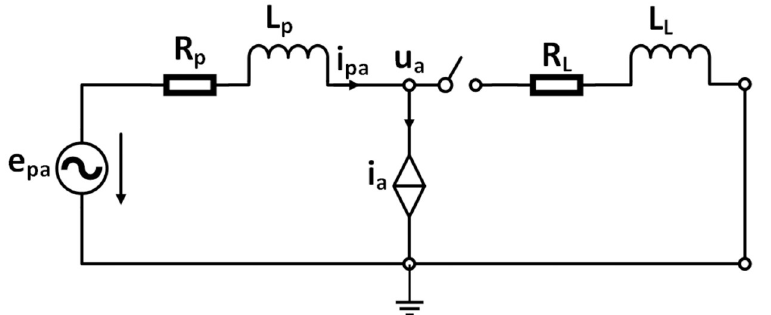
Fig 2. Single-phase equivalent circuit from